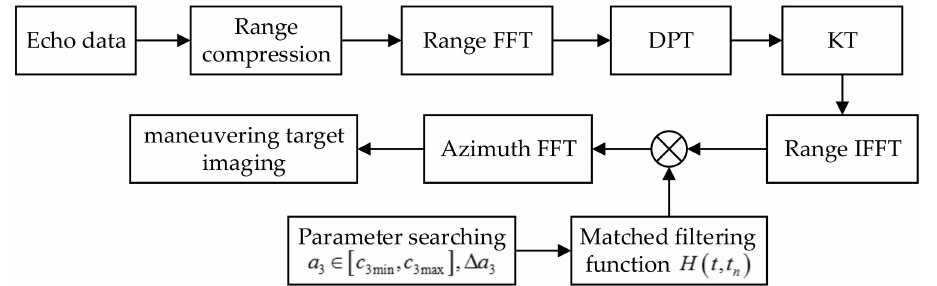
Figure 3. Processing steps of the presented discrete polynomial-phase transform (DPT), keystone transform (KT), and matched filtering processing (DPT–KT–MFP) algorithm.